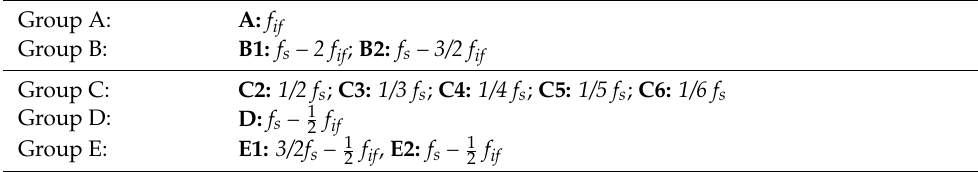
Figure 18. Measurements of susceptibility of the RF receiver LUN related to undesired signals of power electronics. Table 1. Intermediate frequency of the